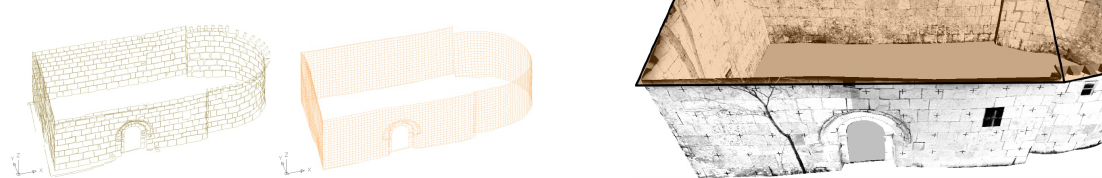
Figure 16. Model with photographic textures of the hermitage of Andra